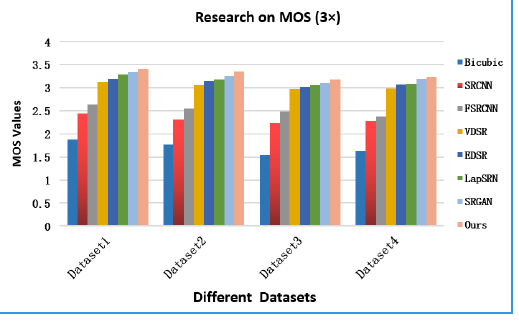
Figure 12. Compared MOS results with a 3× scale on Dataset 1, Dataset 2, Dataset 3, and Dataset 4.